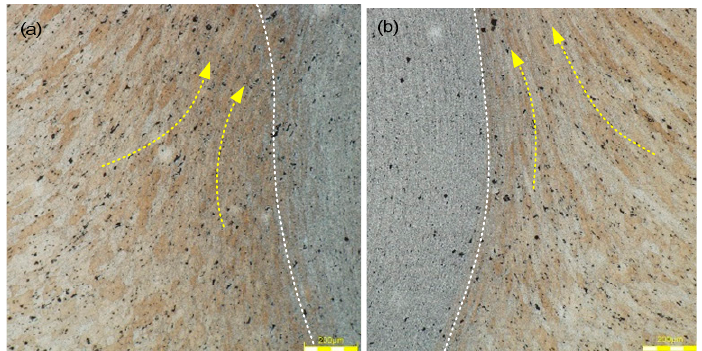
Figure 20. The boundary and material flow between the weld nugget zone (WNZ) and the thermo- mechanically affected zone (TMAZ). ( a ) The boundary area between the WNZ and the TMAZ on the advancing side; and ( b ) the boundary area between the WNZ and the TMAZ on the retreating side.